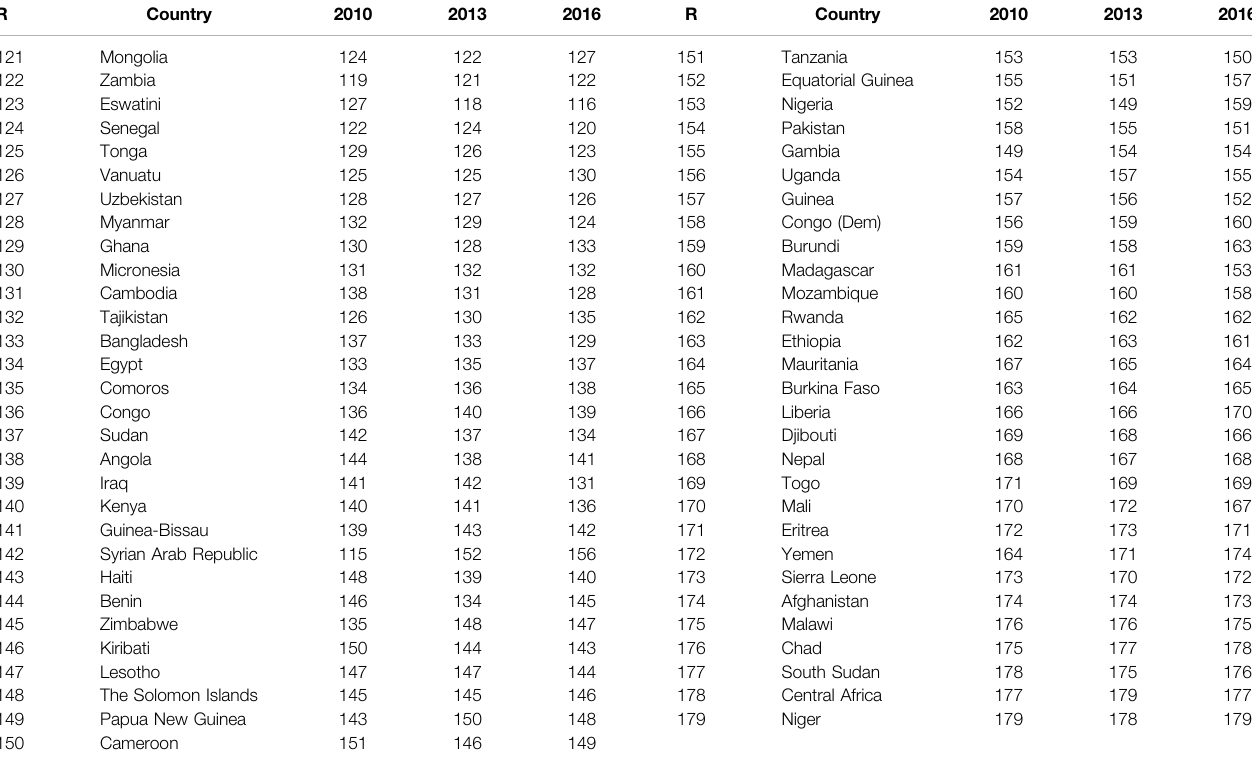
TABLE 6 | Rankings of low-NSDI